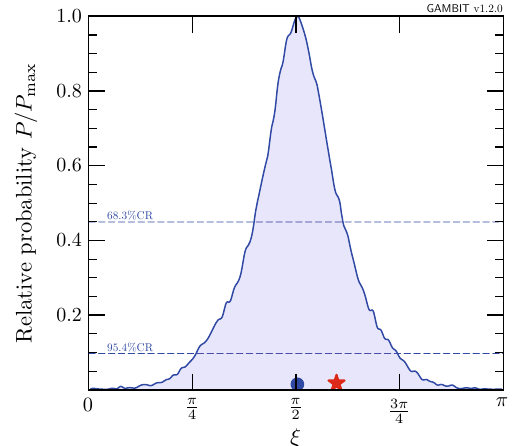
Fig. 11 Marginalised posterior distribution for the mixing angle ξ for Majorana fermion DM in the full-mass-range scan. The posterior mean is shown by a blue circle, while the maximum likelihood point is shown as a red star